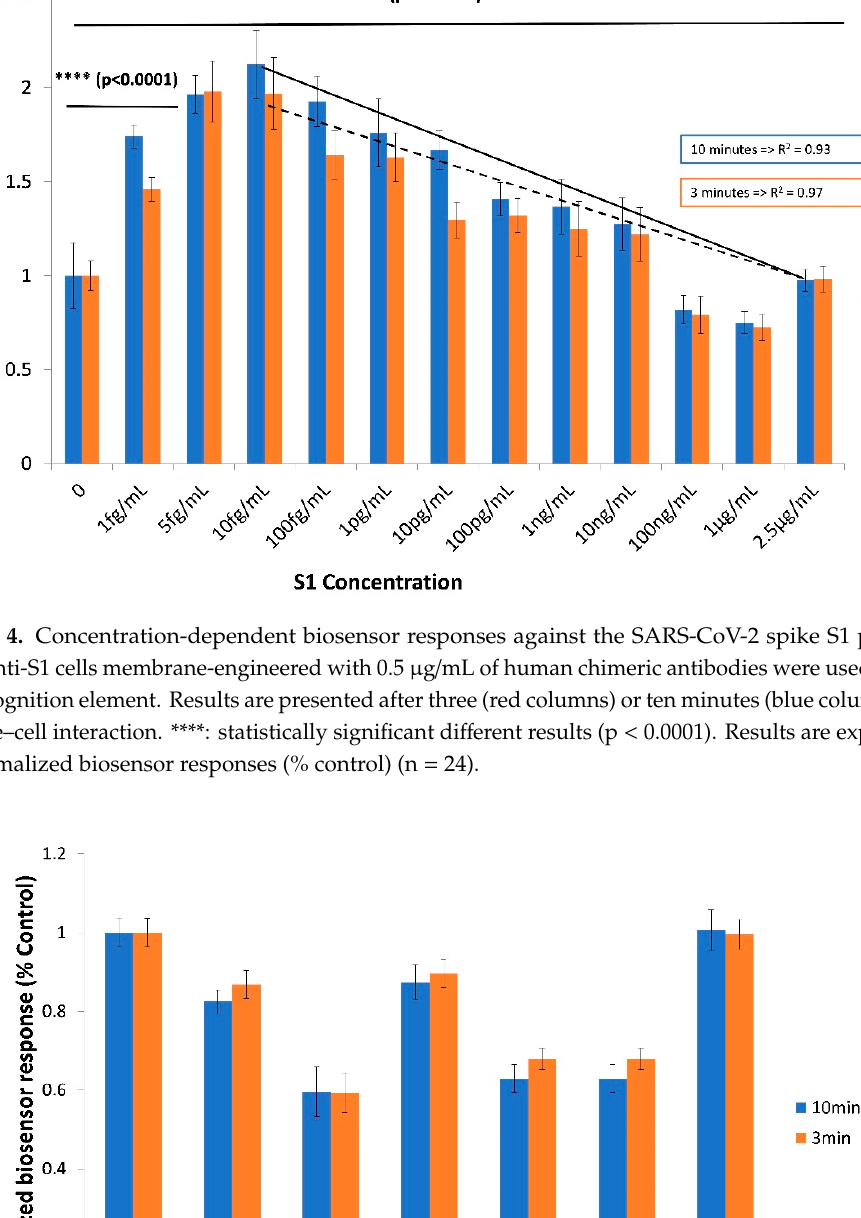
free electrodes. Results are presented after three (red columns) or ten minutes (blue columns) of